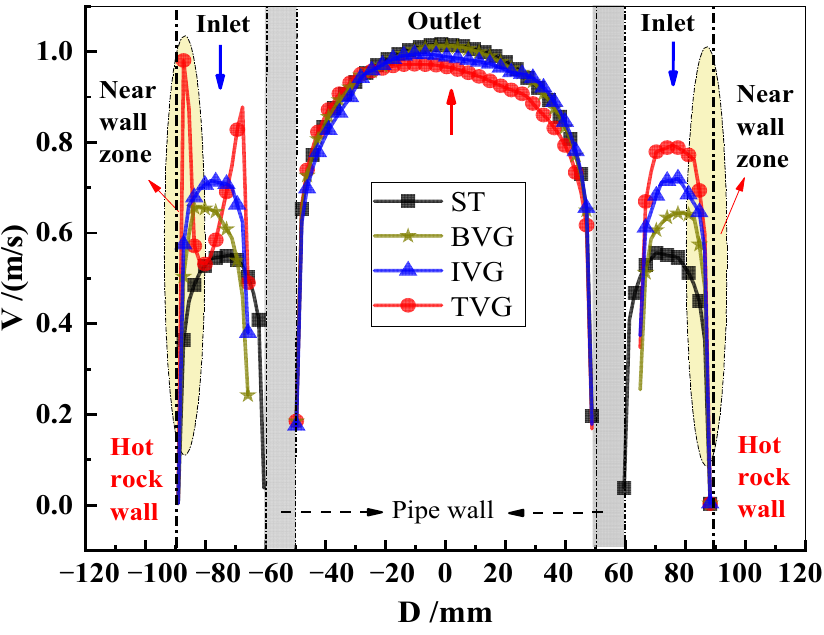
Figure 10. Velocity variation curves along the radial direction of cross-section Plane1 of four heat exchangers. four heat